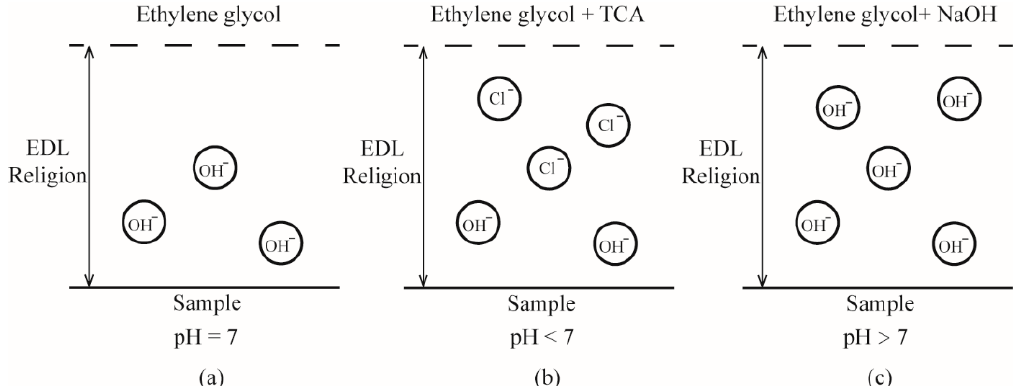
Figure 5. Schematic of the surface charge on the superoleophilic, oleophobic, and superoleophobic surface immersed in ethylene glycol with value of ( a ) pH = 7, ( b ) pH < 7, and ( c ) pH > 8.